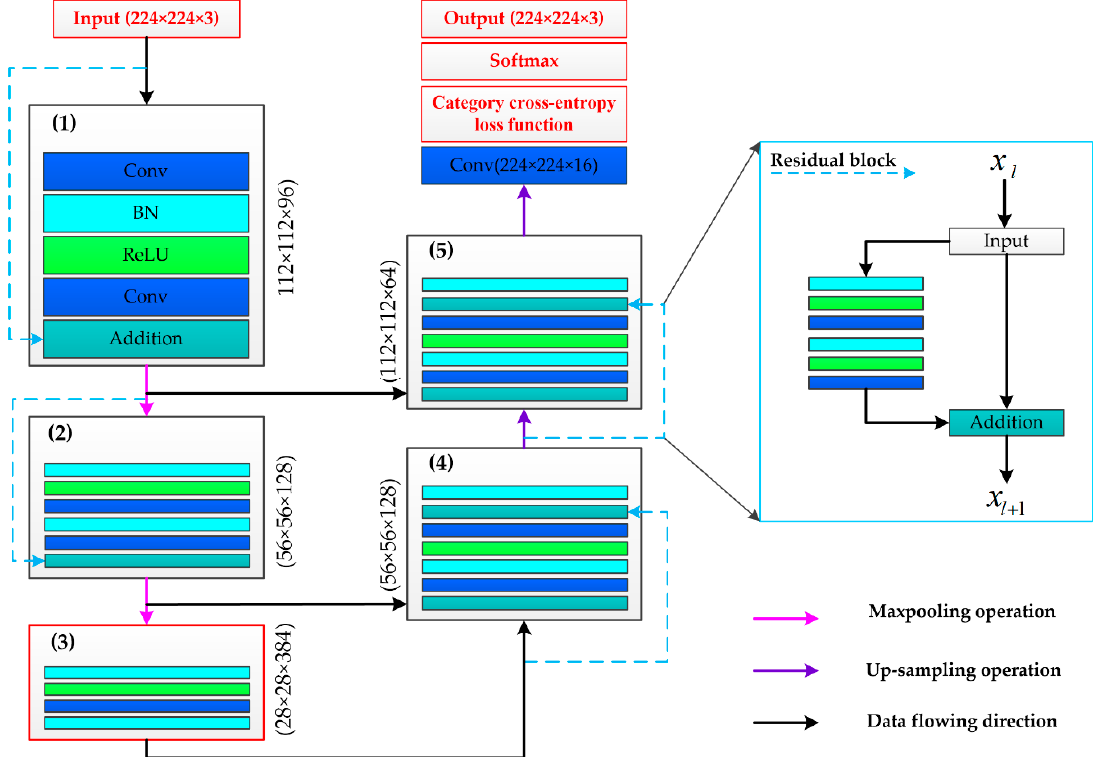
Figure 2. The architecture of the revised residual U-Net network for building change detection. Dashed lines in blue represent the residual block plotted in the right blue box. The abbreviation Conv means convolution, BN means batch normalization, and ReLU means an activation function with the rectified linear unit.